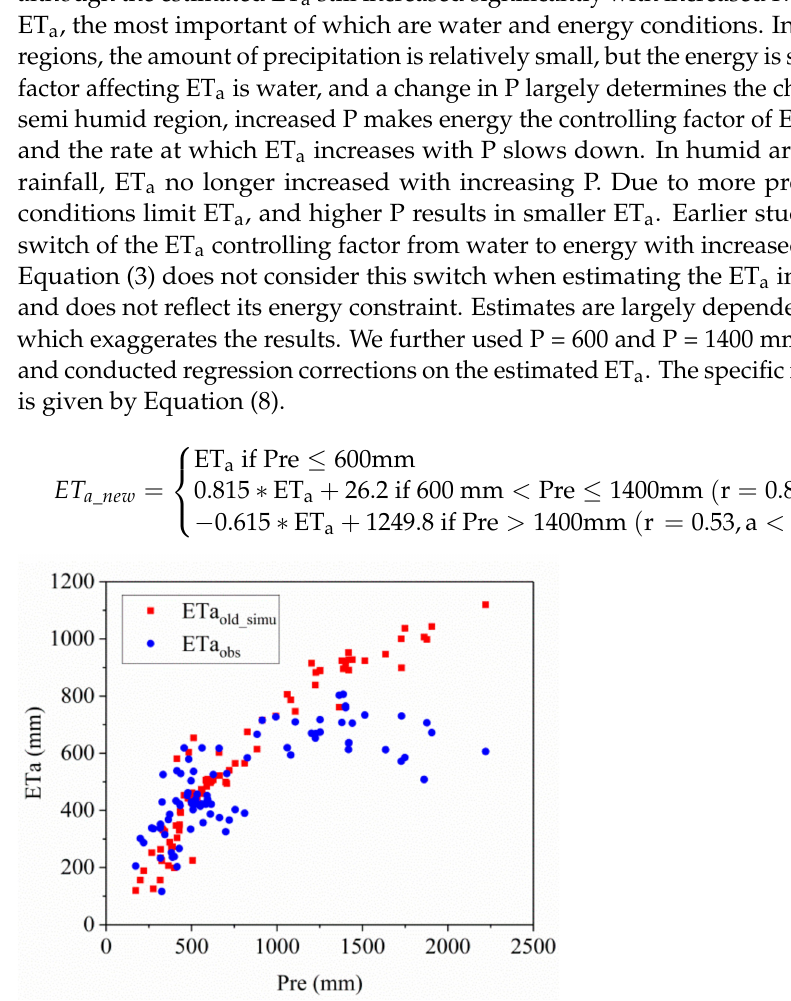
Figure 2. Distribution of observed and estimated ET a with